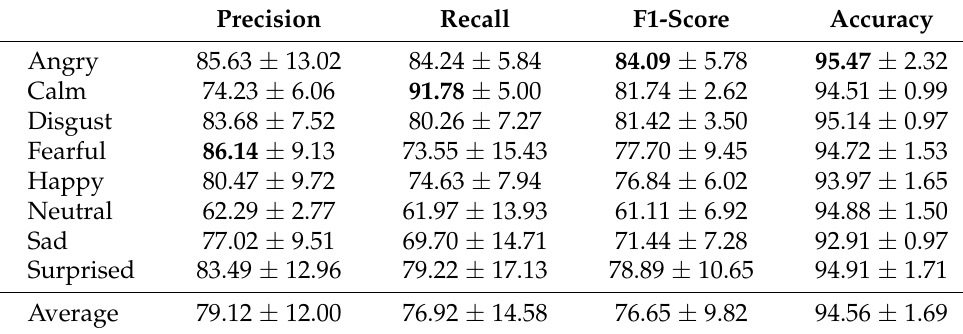
Table 6. Speaker-dependent emotion recognition. Average ( ± standard deviation) precision, recall, F1-score, and accuracy across 5-cv iterations. In each column, the best results are marked in boldface .